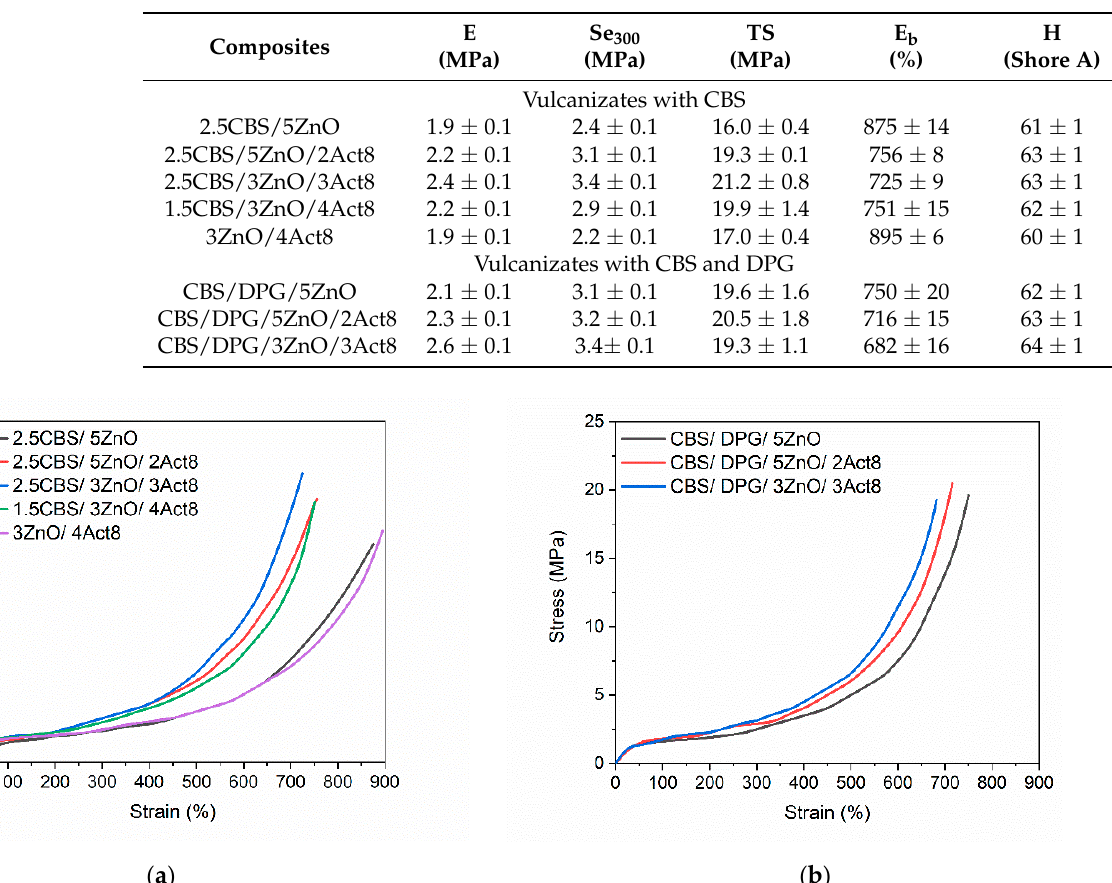
Table 4. Tensile properties and hardness of SBR vulcanizates (E, Young’s modulus; Se 300 , stress at 300% relative elongation; TS, tensile strength; E b , elongation at break; H, hardness). Composites